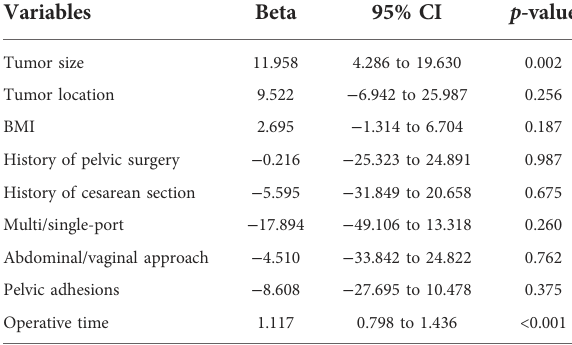
TABLE 3 Association between procedure time and myomectomy types.